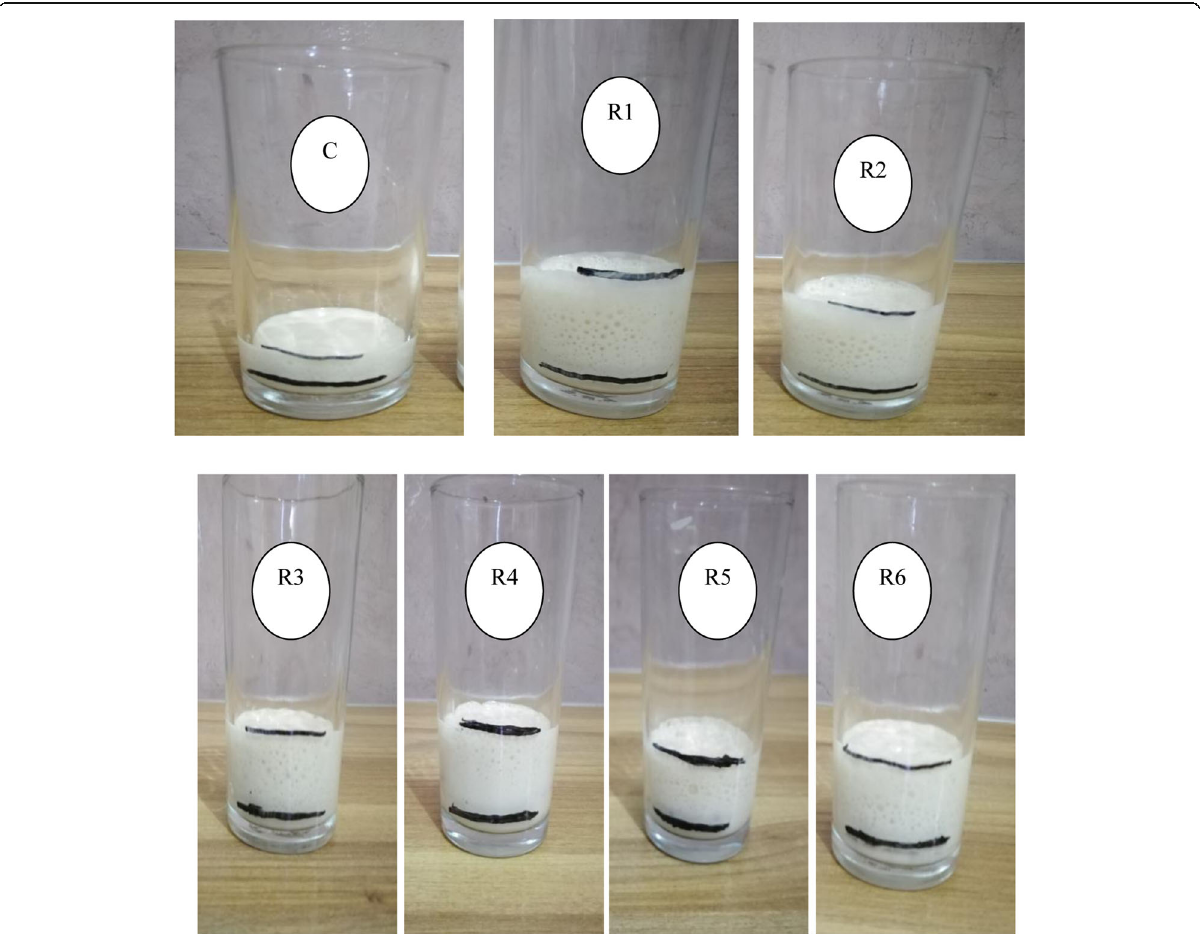
Fig. 10 Application of immobilized α -amylase and its reusability for dough-raising in bakery (R1, R2, R3, R4, R5 and R6) and control without α - amylase addition